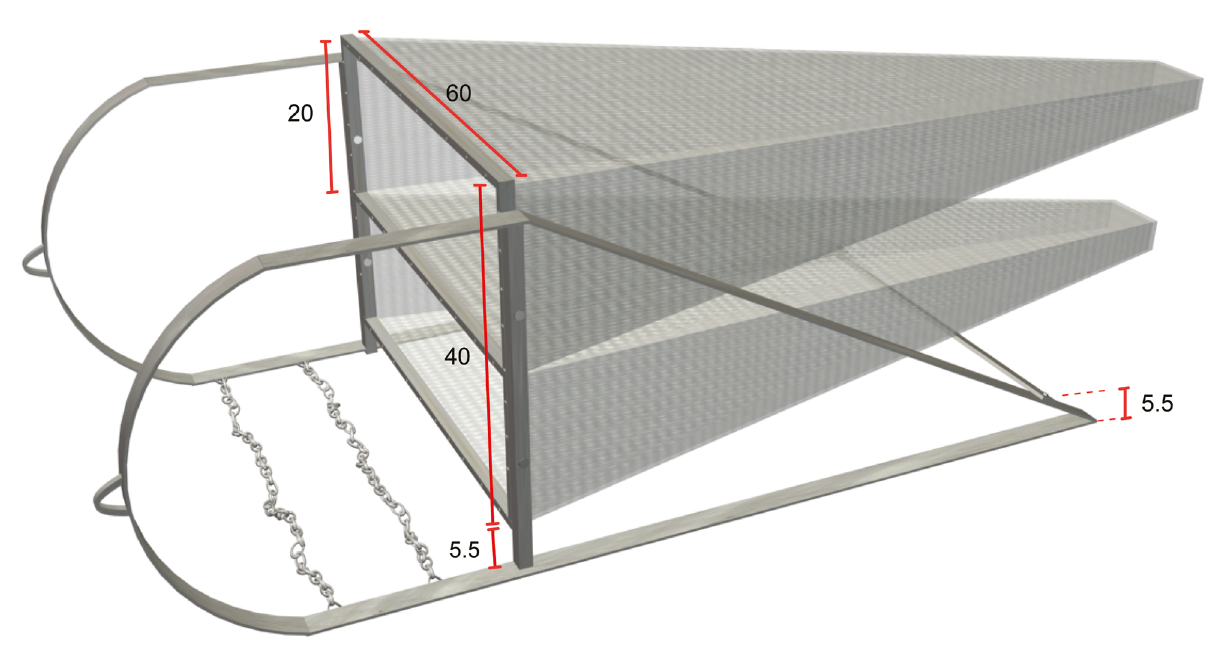
Figure 2. A Diver Operated Epibenthic Sledge. Dimensions are in centimeters.